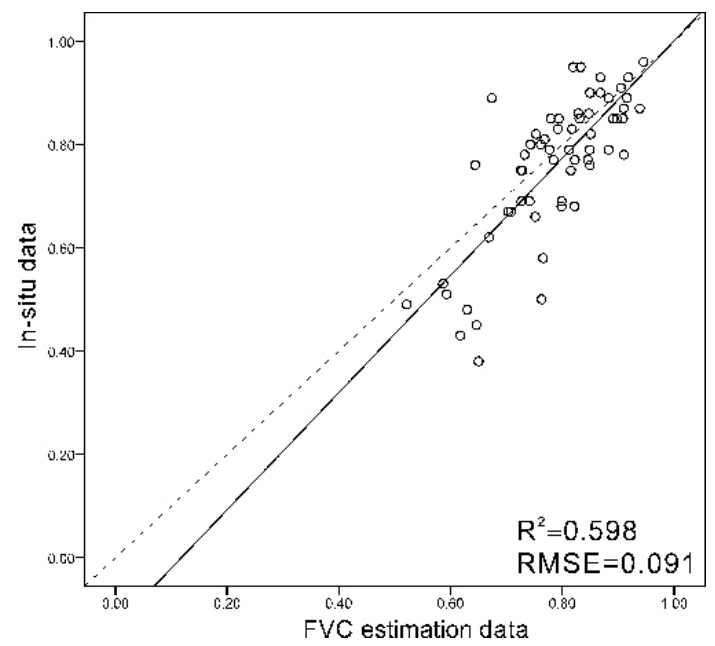
Figure 5. The linear relationship between in-situ data and FVC estimation data using DPM. The x-axis gives the FVC estimation data in the year 2015, while the y-axis gives the in-situ data measured in 2015. The solid line is the linear fitting line, the dash line is the 1:1 line. r = 0.773 ( p < 0.01), R 2 = 0.598, RMSE = 0.091 ( n = 60).